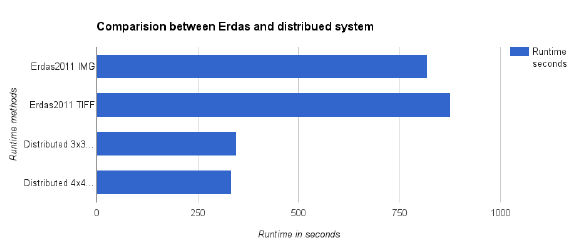
Figure 8: Comparision between Erdas and distributed system in